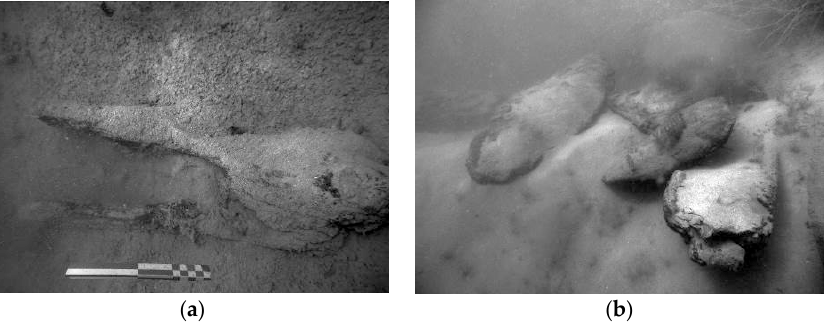
Figure 16. Fragments of piroga found during underwater surveys in Lago Tramonto, Gambulaga, Portomaggiore (FE, Italy): ( a ) Stern or bow; ( b ) Hull (photo by Giovanna Bucci).